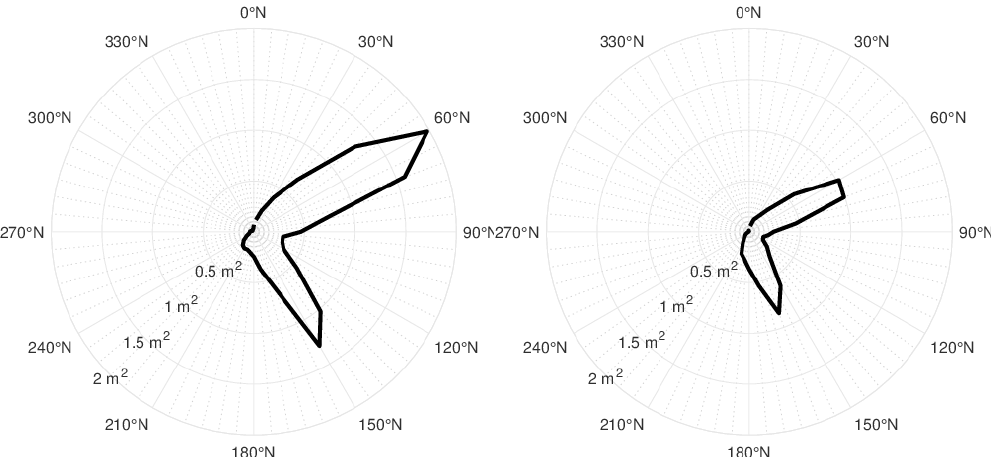
Figure 7. Offshore Energy polar plot relative to point P1 (left), point P2 (right) summarising the wave rose in Figure 6.